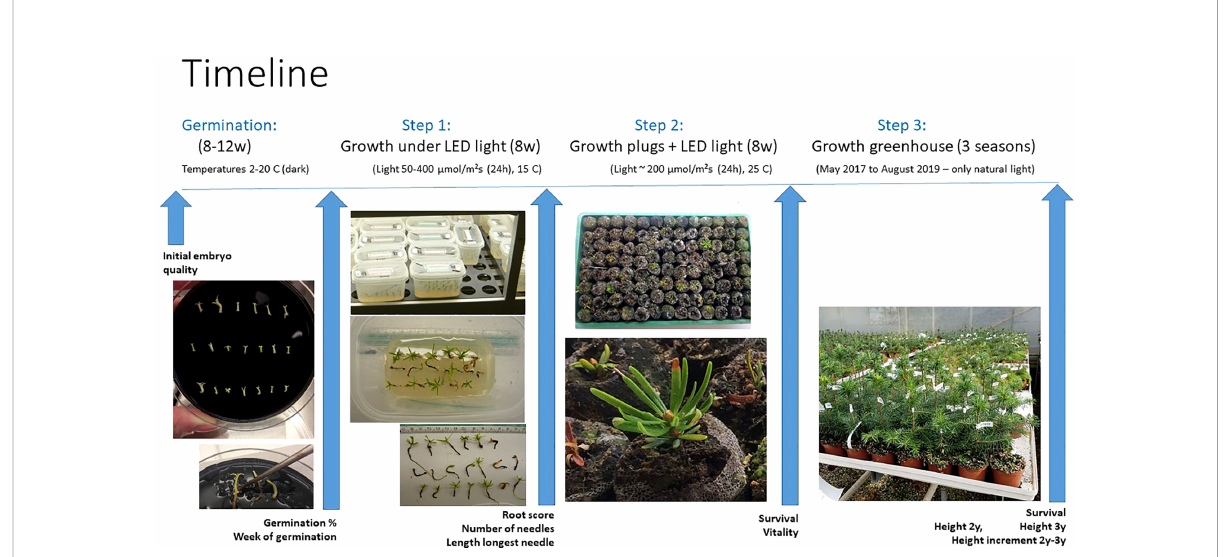
FIGURE 2 Overview of the timeline for the SE process steps monitored in the study. Germination of embryos for 8-12 weeks in darkness at different temperatures between 2°C to 20°C. Step 1: plant growth for 8 weeks under LED light (50-400 μmol m -2 s- 1 ¸24 h) at 15°C. Step 2: plant growth after transplanting into peat plugs for 8 weeks under LED light (180-200 μmol m -2 s -1 , 24 h) at 25°C. Step 3: plant growth for 3 years in a commercial nursery with natural light. The measurements carried out at each step are de fi ned under the blue